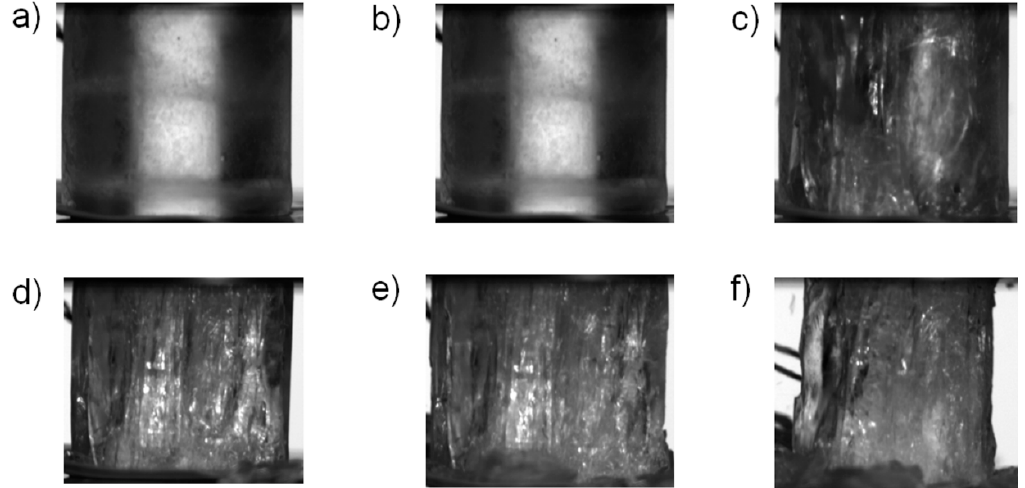
Figure 10. Examples of video frames recorded in the quasi-static test QS_m20_07: ( a ) prior to loading, ( b ) immediately prior to the first drop in load (eng. stress = 8.7 MPa), ( c ) 0.1 s after the previous frame, ( d ) at maximum load (eng. stress = 11.7 MPa), ( e ) after maximum load, immediately prior to the final failure (eng. stress = 8.4 MPa) and ( f ) 0.3 s after the previous frame (zero load). The full video is provided as supplementary material S5.